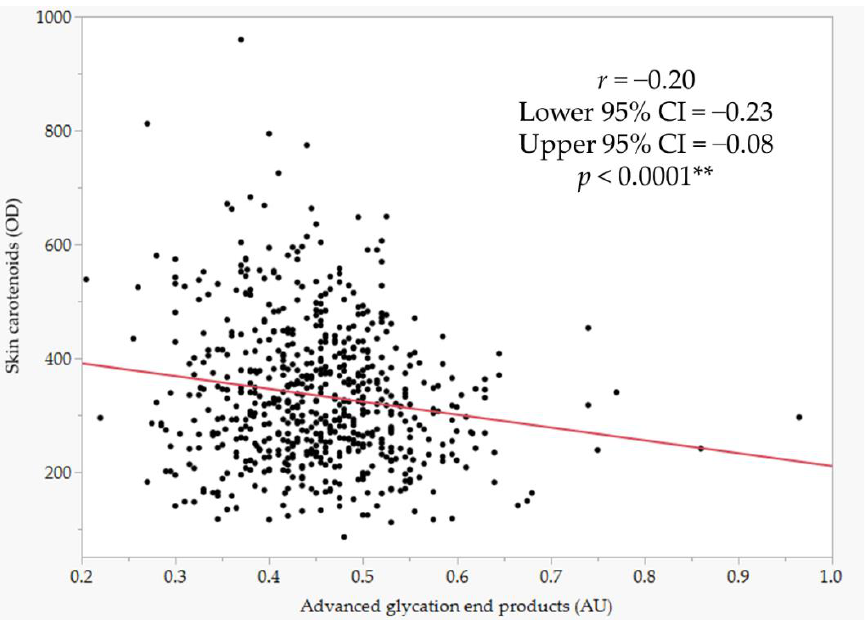
Figure 1. Single regression of AGEs and SCs. The p -value was estimated by a linear regression analysis. Significance level at 1% ( p < 0.01) **.